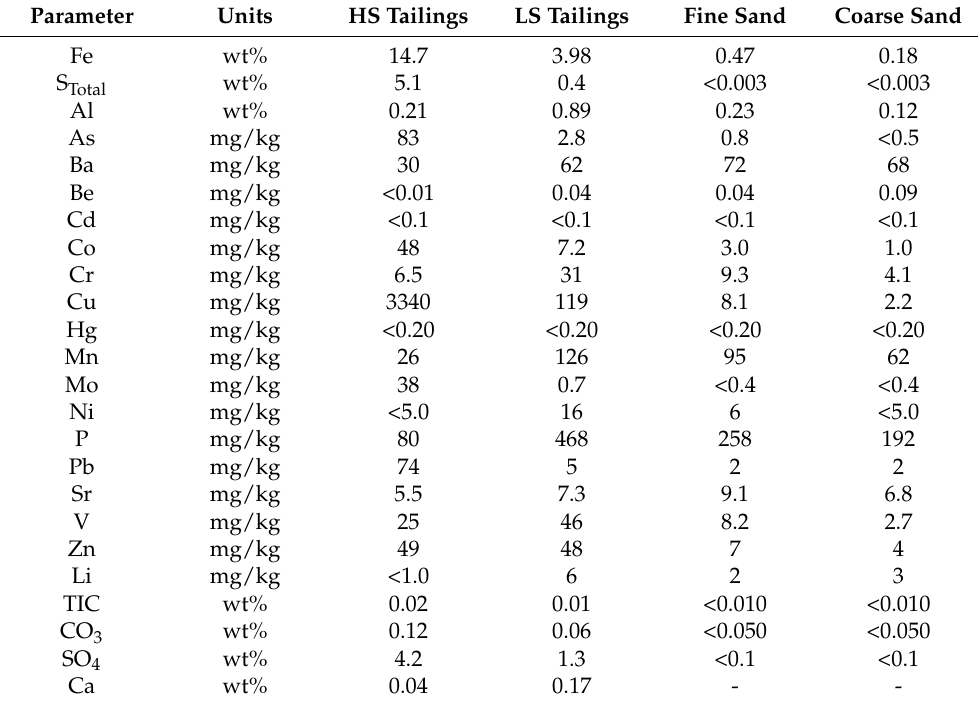
Table 1. Chemical composition of the HS tailings, LS tailings, fine sand, and coarse sand used in the column tests.